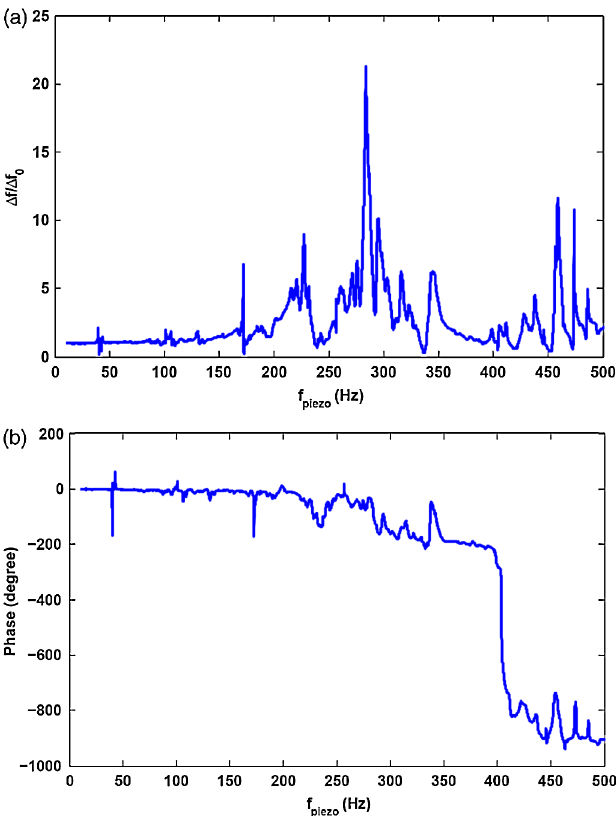
FIG. 11. (Color) Transfer function between harmonic piezo excitation and cavity rf response vs piezo frequency for the Saclay II tuner. Plot (a) shows the normalized amplitude re- sponse while (b) exhibits the phase lag between excitation signal and rf